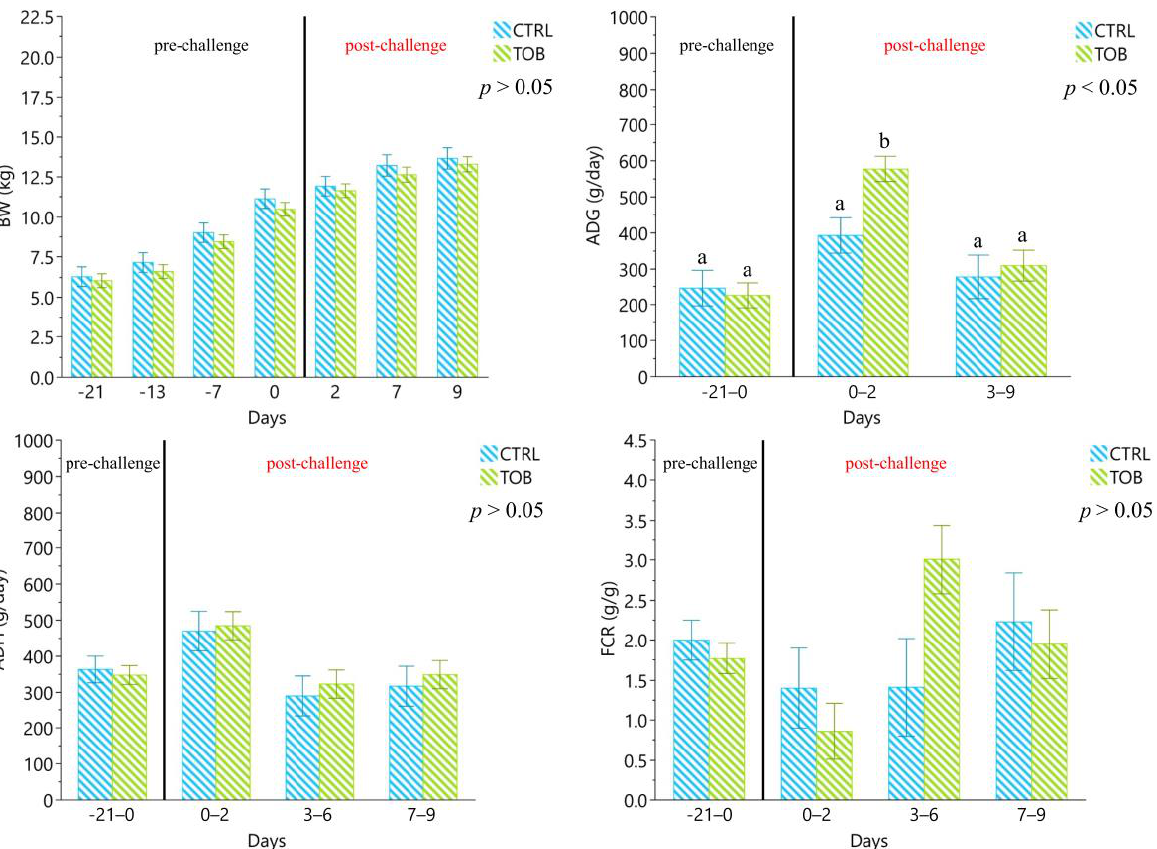
Figure 1. Zootechnical performance from 0 to 29 days of the experimental trial. UC: unchallenged control group, UT: unchallenged treatment group, CC: challenged control group, CT: challenged treatment group. a,b Different lowercase letters indicate statistically significant differences ( p < 0.05). The results are presented as least squares means ± standard error.